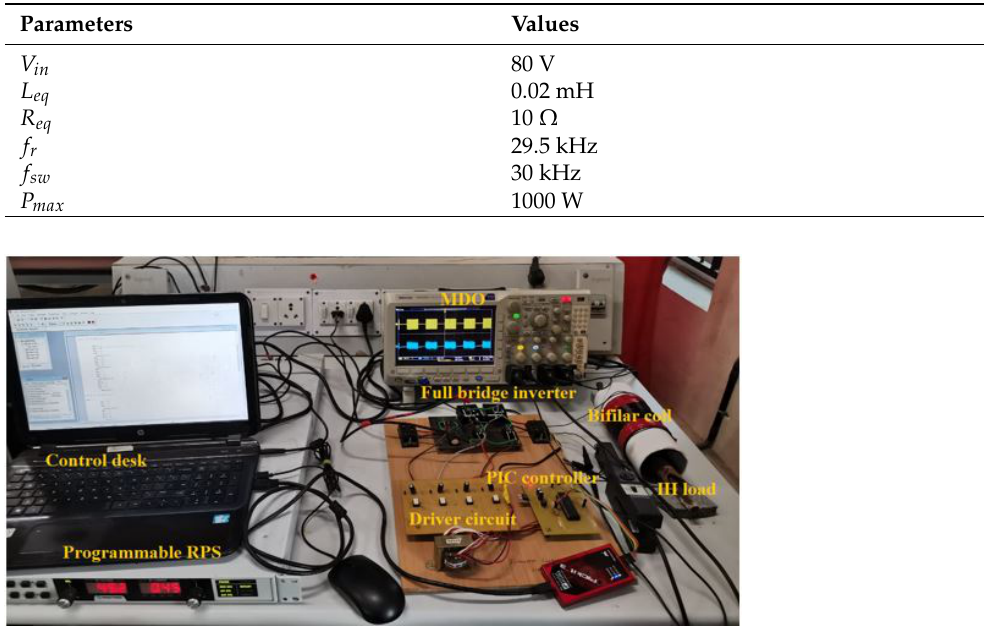
Figure 6. Test setup of the bifilar coil-based IH